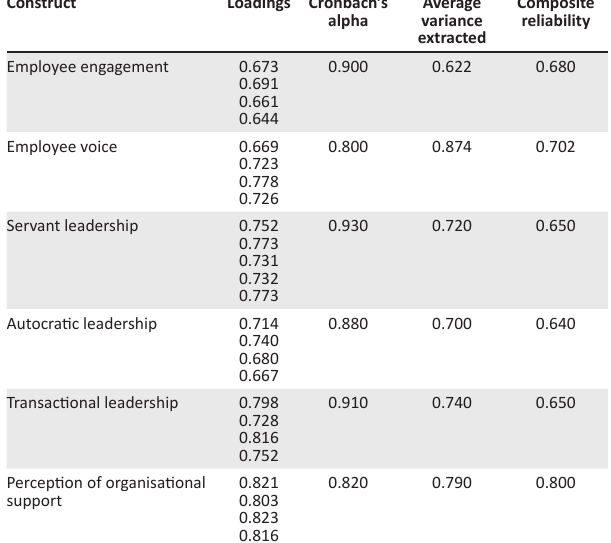
TABLE 2: Convergent validity.